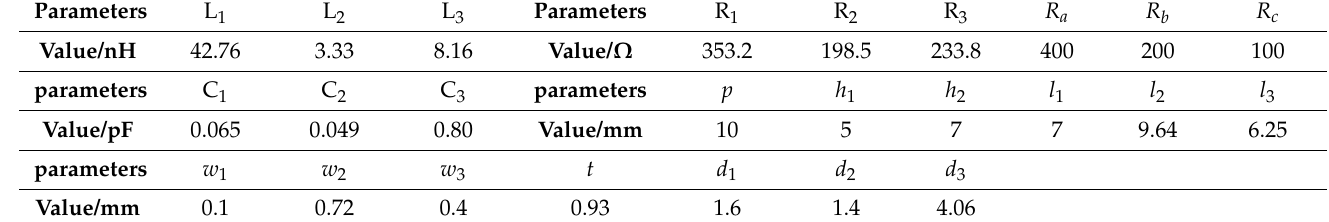
Figure 4. Extract imaginary ( a ) and real ( b ) parts of Y d1 , Y d2 , and Y in . The pink part represents the frequency band that meets the resonance requirements.